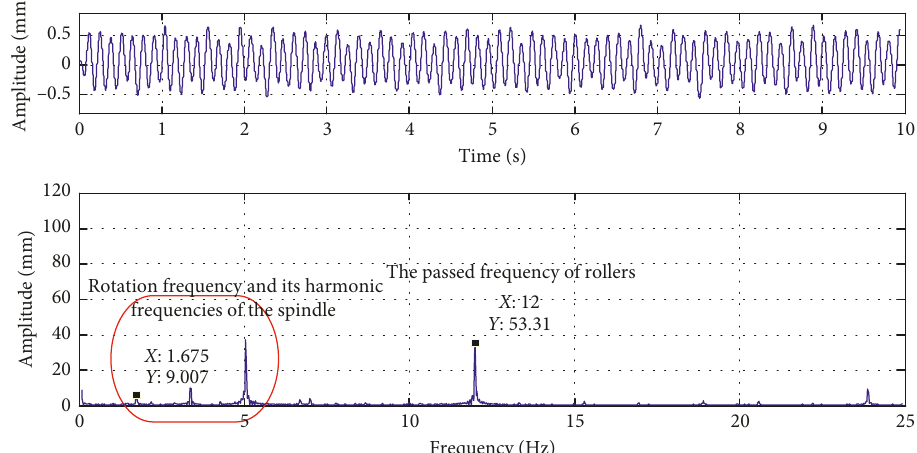
Figure 13: The time-domain diagram and the spectrum diagram of the quality qualification